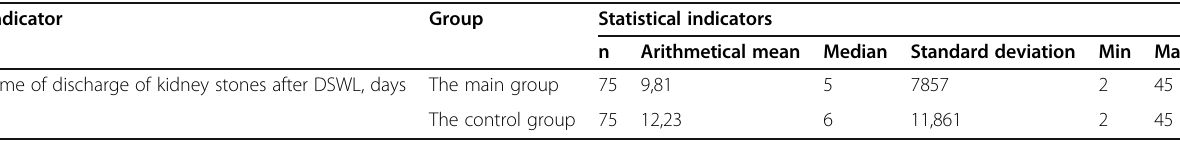
Table 6 Analysis of groups by the time of passage of kidney stones after DSWL Indicator